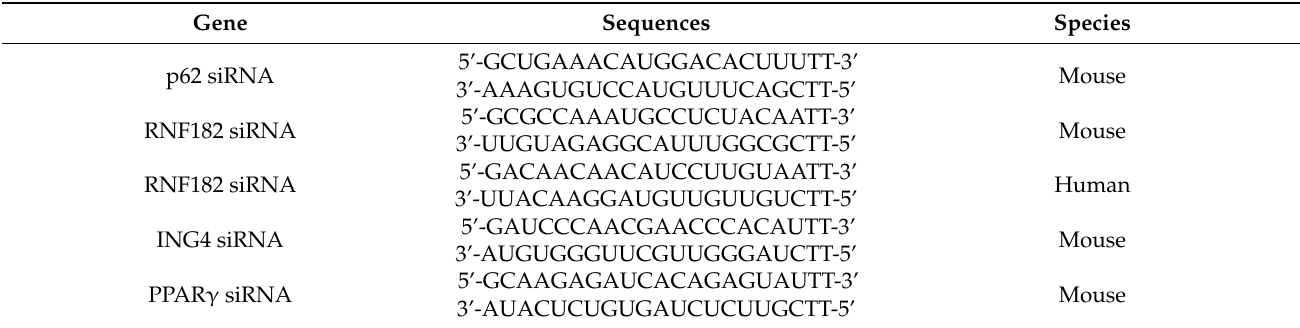
Table 3. The sequences of target siRNAs in this study.